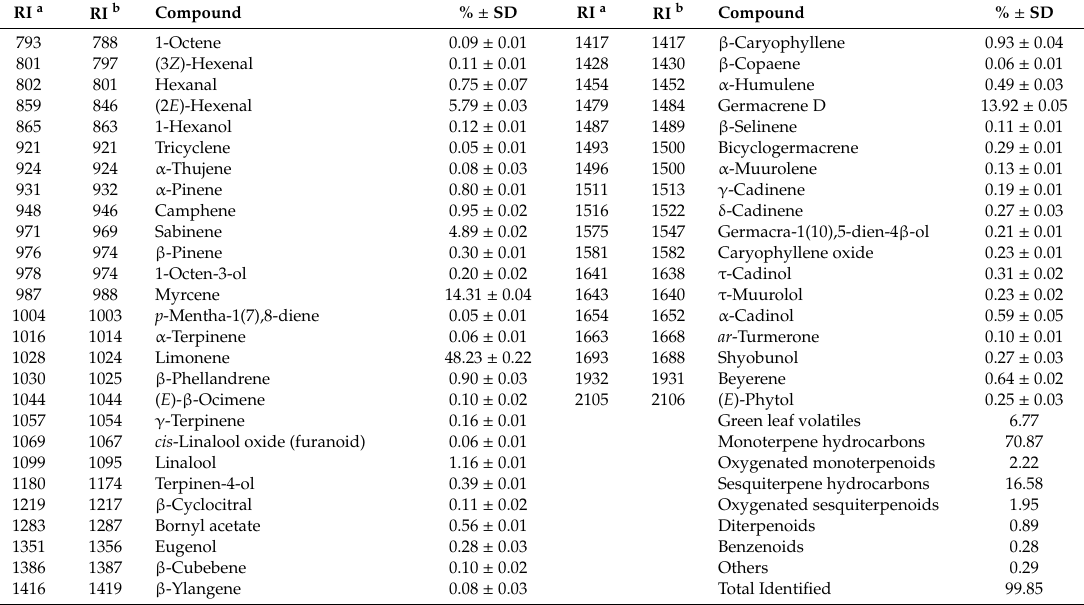
Table 11. Chemical composition of the essential oil of Xanthium strumarium L.